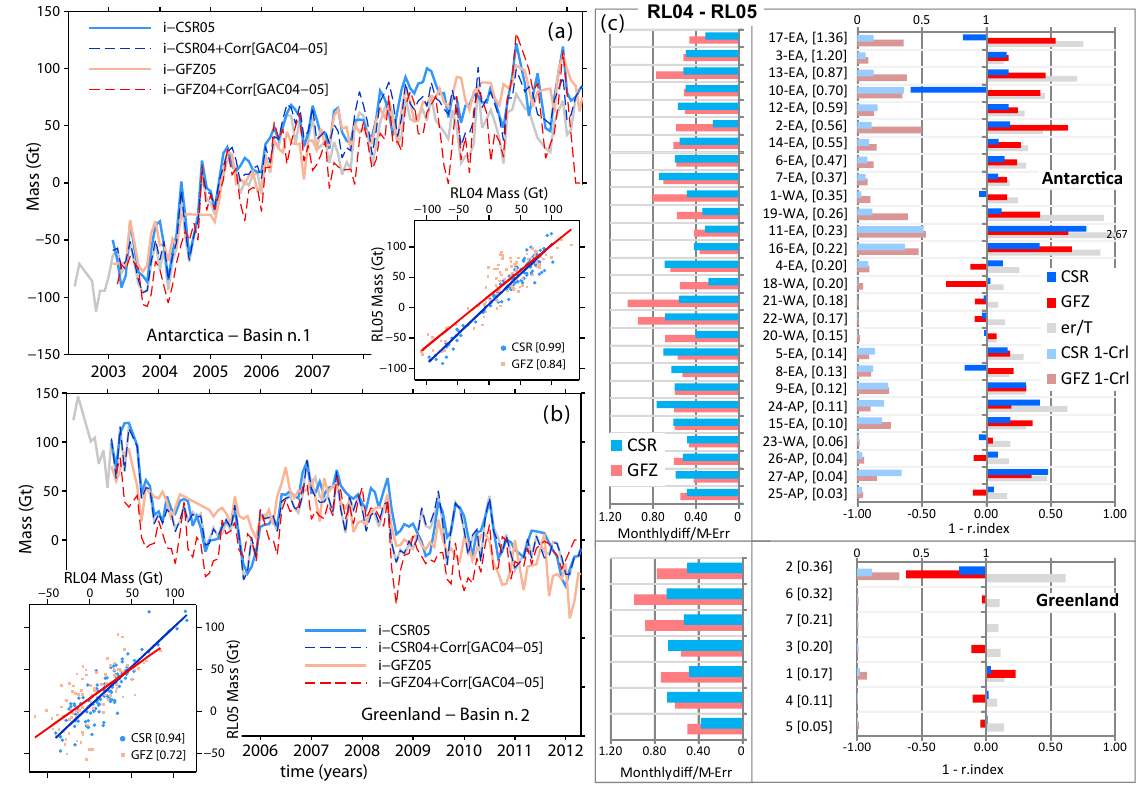
Fig. 5. Monthly solution for basin 1 for Antarctica (a) and basin 2 for Greenland (b) . Comparison between the two releases RL04 and RL05 (CSR and GFZ) with inversion method: the use of CSR is indicated by light-blue and blue lines, and the GFZ by light-red and red lines. The release RL05 is the solid line, while the RL04, with GAC[04–05] correction, is the dashed line. The grey line represent the original CSR time series before the GAC correction. Each of the small dispersion graphics shows the time series obtained with RL04 versus RL05 with the use of CSR (blue) and GFZ (red). Note that GFZ RL05 has several months missing in 2004 and that is the reason for the anomaly in the plot. In panel (c) , for each basin differences between RL04 and RL05 are plotted for the use of CSR (blue) and GFZ (red). The light colors represent (the quadratic sum of) the monthly difference with respect to (the average of) the monthly errors. The normal colors represent 1 /T 2 as in Eq. 4, and the grey bar is the error on the same trend as Fig. 8d and Fig. 9d with respect to the minus regression index m , i.e. δ T 21 trend. The very light-blue and dark-pink bar represent 1 minus the correlation coefficient for the use of the two releases of CSR and GFZ, respectively. When the correlation is below 75% (i.e. the related bars are larger than 0.25), the associated regression index is not meaningful. NOTE: the difference in the time span of the RL05 time series is due to an update in data; see note in the